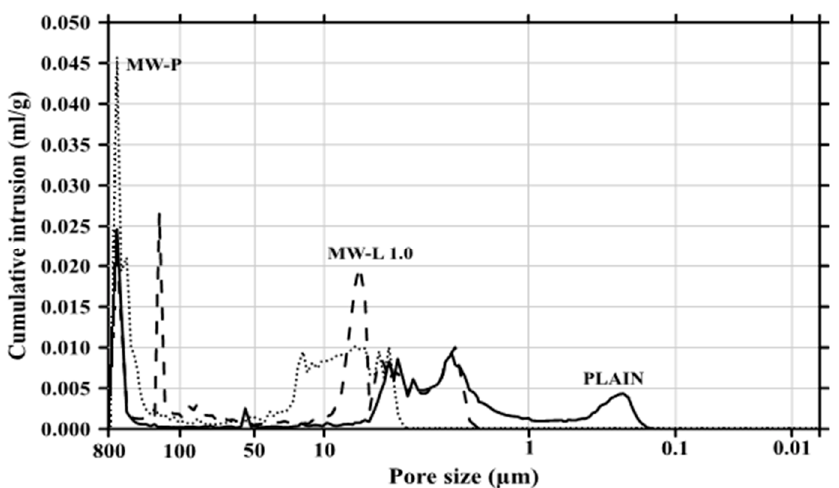
Figure 9. Pore size distribution.